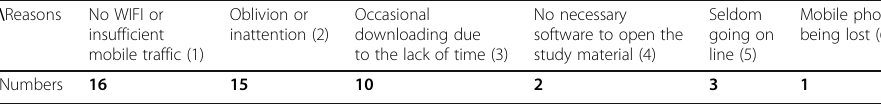
Table 1 Reasons for not downloading online self-study